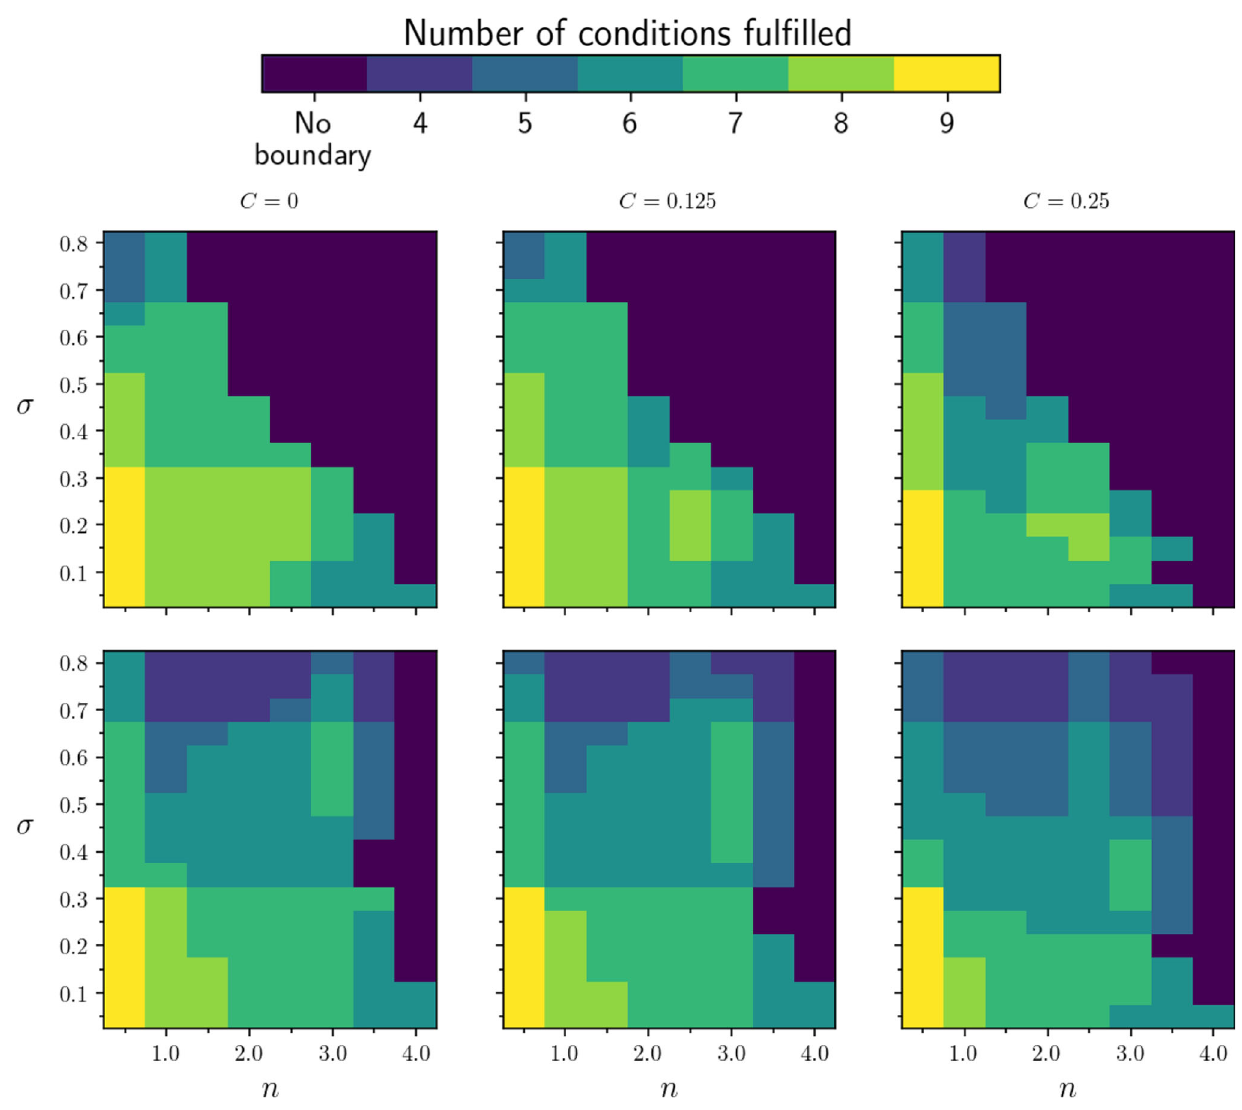
C and σ varying from 0 to 0 . 25 and 0 . 05 to 0 . 8, respectively. None